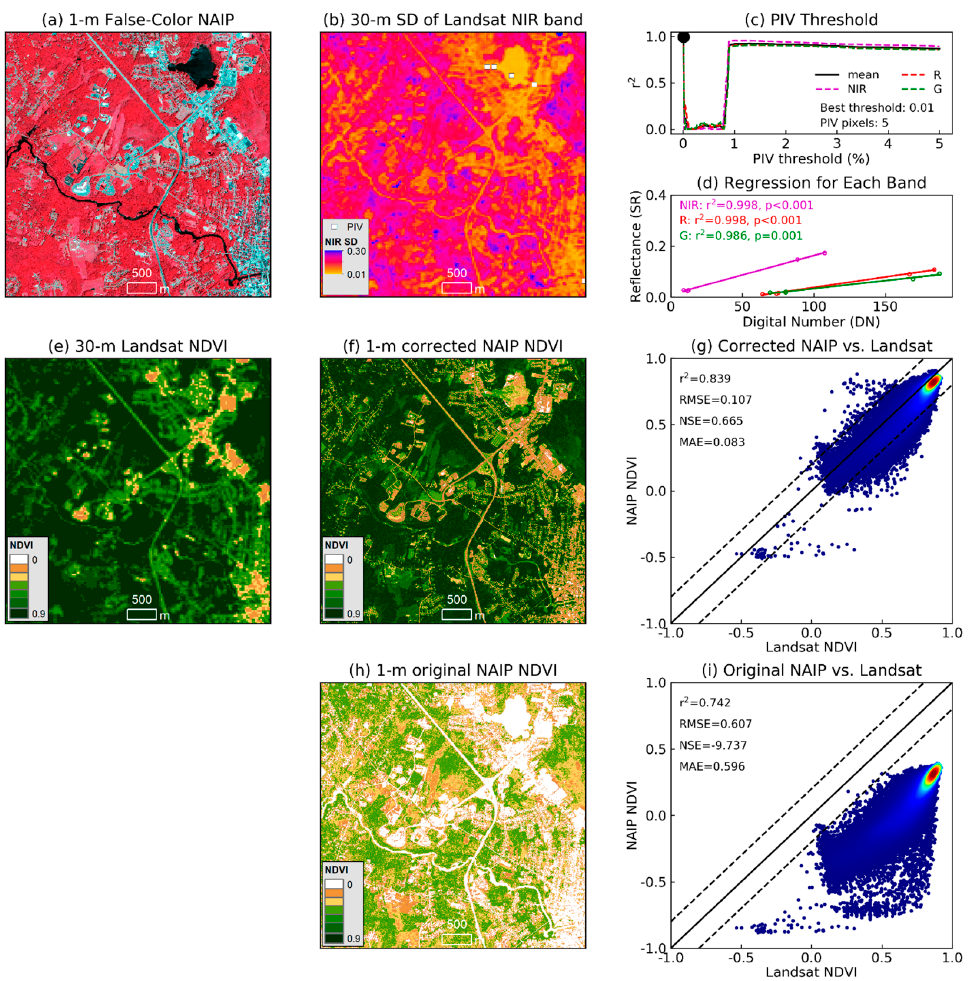
Figure 4. Application of PINT at site 1. Plots ( a )–( d ) demonstrate the identification of pseudoinvariant (PIV) pixels: plot ( a ) shows the 1 m false-color National Agriculture Imagery Program (NAIP) image (near-infrared (NIR), red and green bands) before radiometric correction; plot ( b ) shows pseudoinvariant features (white squares) identified from the 10 year NIR standard deviation of Landsat TM and ETM+ images; plot ( c ) demonstrates the identification of the best threshold (0.01st percentile); and plot ( d ) shows the linear regressions of Landsat surface reflectance and NAIP digital numbers based on pseudoinvariant pixels. Plots ( e )–( i ) show the validation of the normalized difference vegetation index (NDVI) values: plot ( e ) shows 30 m Landsat NDVI as the reference; plots ( f ) and ( h ) show 1 m NAIP NDVI before and after correction, respectively; and plots ( g ) and ( i ) show the agreement with Landsat reference before and after correction, respectively. The solid line is the 1:1 line, indicating a perfect match between NAIP and Landsat NDVI values, and the dashed lines represent the upper and lower 10% error bounds.